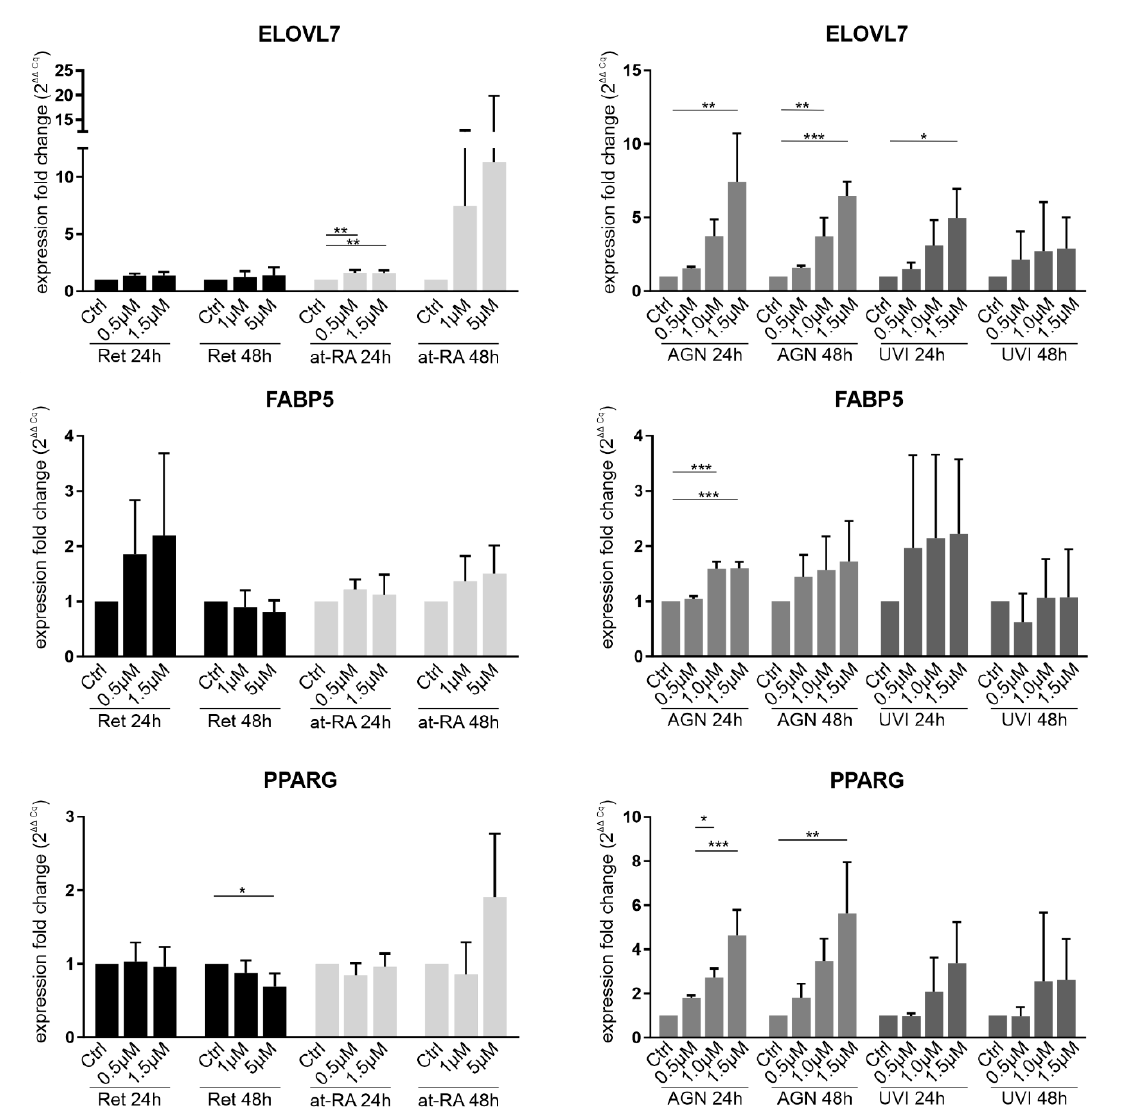
Figure A2. qRT-PCR analysis of ELOVL7, FABP5, and PPARG transcripts in primary limbal epithelial cells (LEC) treated with retinol (Ret), all trans-retinoic acid (at-RA), AGN 193109 (AGN), or UVI 3003 (UVI), for 24 h and 48 h, respectively. The transcripts shown here are related to retinoic acid pathways (from literature search) and were found to be deregulated in the conjunctiva of aniridia patients [9]. ELOVL7 was upregulated after the 24 h RA treatment using the t0.5 µM (FC = 1.6) and 1.5 µM concentrations (FC = 1.6). Higher AGN concentrations, such as the 1.5 µM concentration for 24 h (FC = 7.4) or 1.5 µM for 48 h (FC = 6.5), led to the upregulation of ELOVL7. UVI treatment for 24 h using the 1.5 µM (FC = 5) concentration led to an upregulation of ELOVL7 expression. FABP5 expression was upregulated after 24 h AGN treatment with 1.0 µM (FC = 1.6) and 1.5 µM concentrations (FC = 1.6). PPARG showed downregulation after 5 µM Ret treatment for 48 h (FC = 0.7). The 1.0 µM and 1.5 µM AGN treatment for 24 h (FC = 2.7 and FC = 4.6) led to PPARG upregulation. After 1.5 µM AGN treatment for 48 h, an upregulation of PPARG was observed (FC = 5.6). * p ≤ 0.05; ** p ≤ 0.01; *** p ≤ 0.001; n = 3.